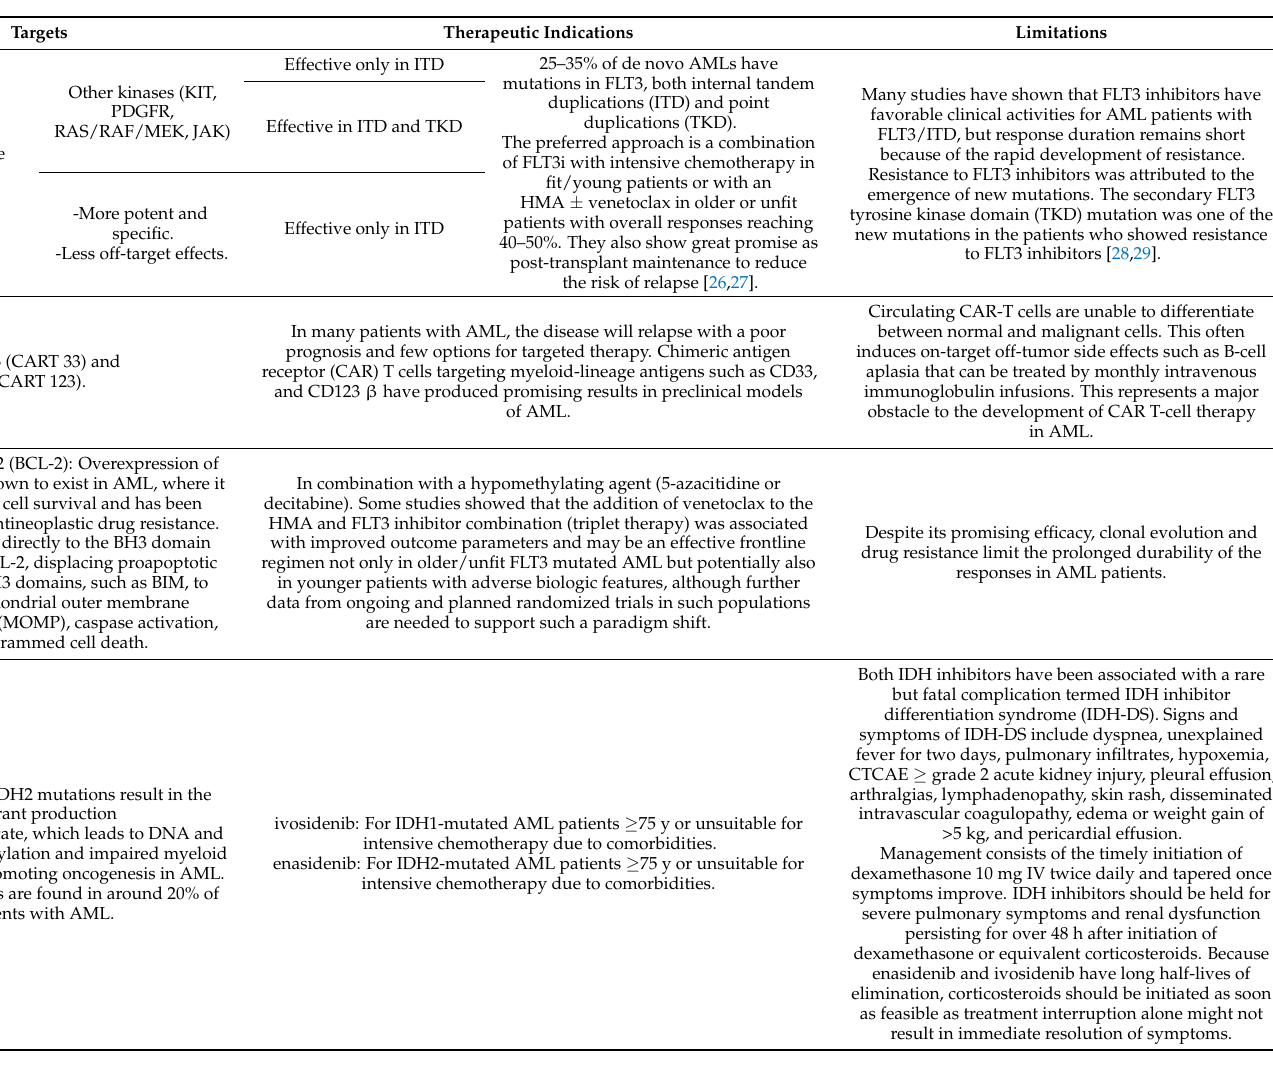
Table 3. New alternative treatment in Acute Myeloid